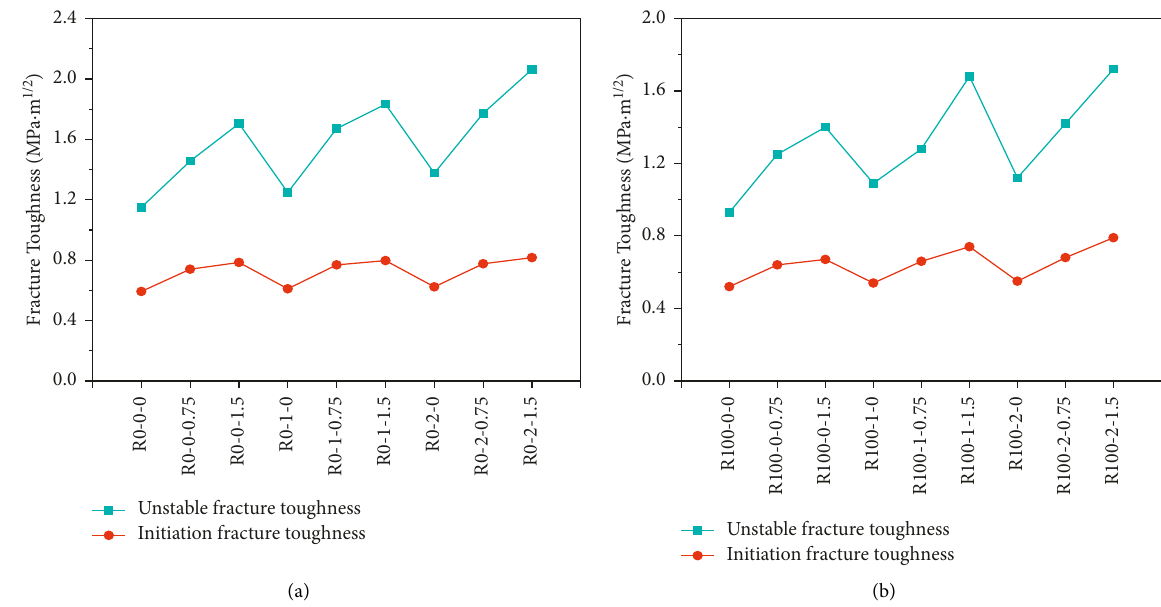
Figure 8: Double-K fracture toughness. (a) Replacement rate of 0%. (b) Replacement rate of 100%.